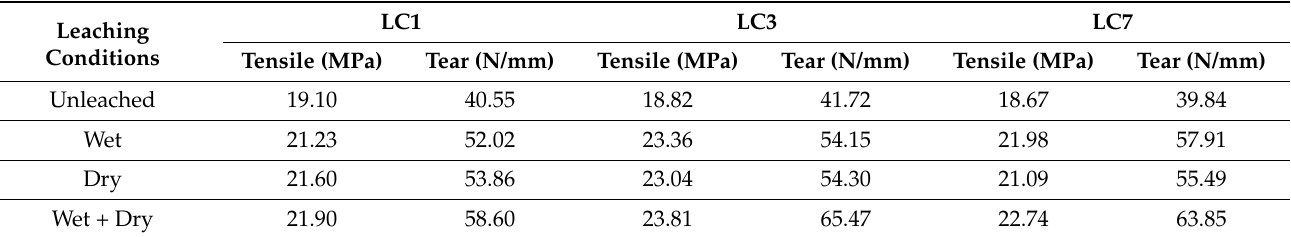
Table 3. Mechanical properties of LC1, LC3 and LC7 film post-processing (wet-gel leaching, dry-gel leaching, and wet and dry-gel leaching).